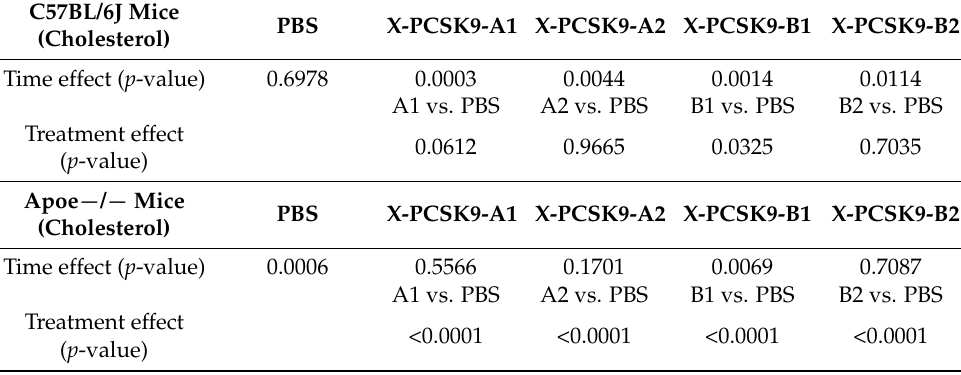
Table 3. Statistical analyses of the time and treatment effects of X-PCSK9 isomers, A1, A2, B1 and B2, on plasma cholesterol in C57BL/6J and Apoe − / −